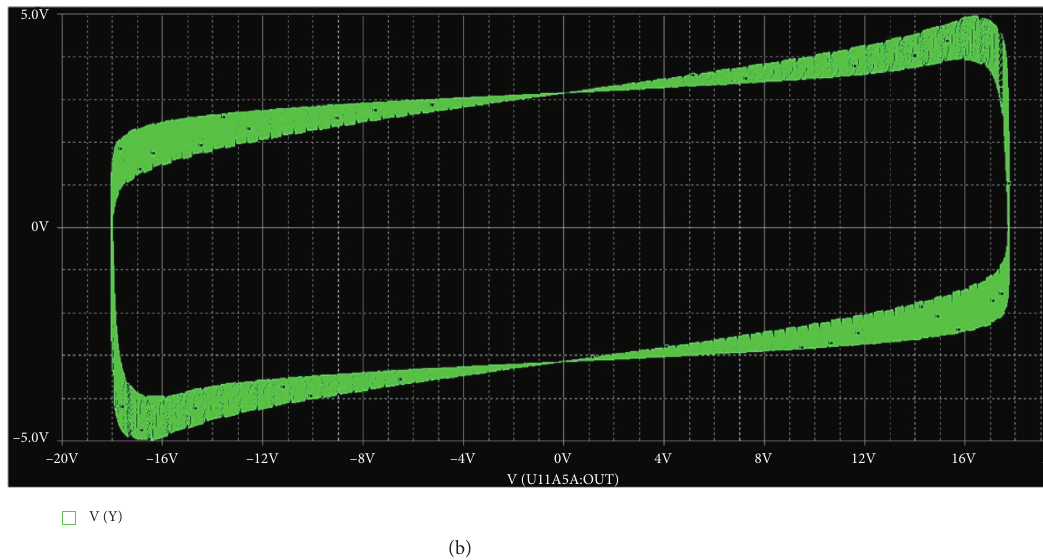
Figure 9: The phase portrait of the simulated circuit. (a) The phase space of the system when w � 0 . 8 and A � 1 (simulated with Matlab 2020). (b) The result of the simulated circuit (Pspice, version